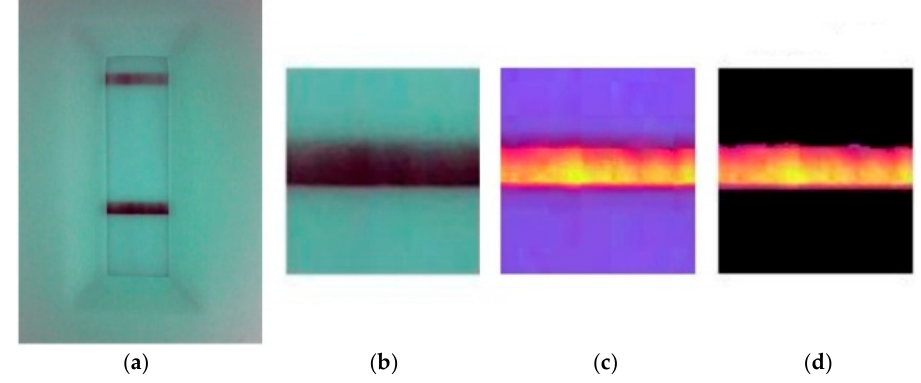
Figure 6. Process of image segmentation. ( a ) Original image; ( b ) the segmented test line; ( c ) HSV image with adjusted brightness; and ( d ) the result of test line segmentation.